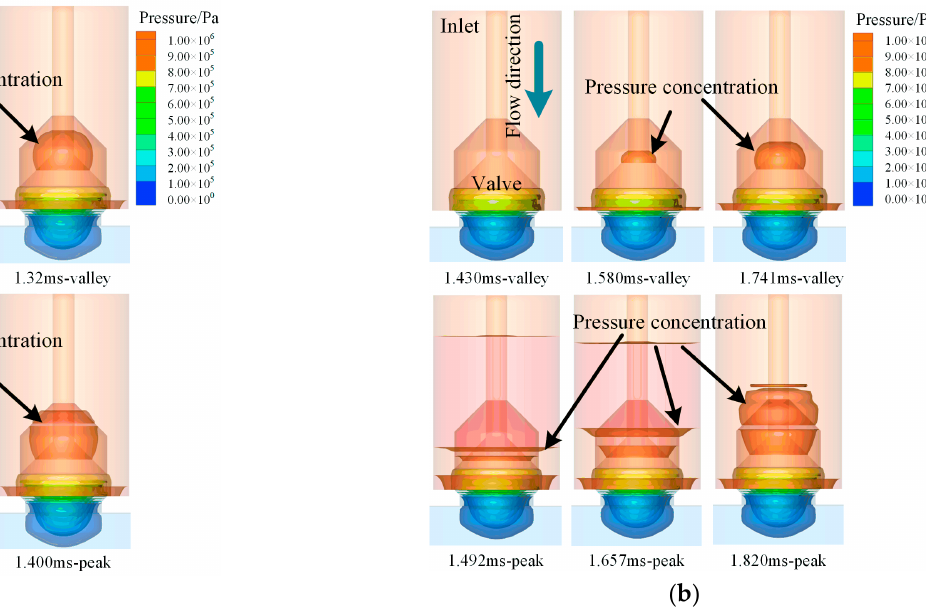
Figure 12. ( a ) Throat near-field pressure distribution of the case with no vibration (left). ( b ) Throat near-field pressure distribution of cases with vibration (case 2, for example; right). It could be intuitively obtained from the near-field pressure distribution that a smaller pressure-concentration zone is formed on the back face of an injector’s valve for the valley point (for example: case with no vibration, 1.162 ms-valley) when compared with that for the nearby peak points (for example: case with no vibration, 1.082 ms-peak and 1.239 ms-peak). In addition, the volume of the pressure concentration area tends to increase as injection time goes by. On the other hand, for the peak point (for example: case